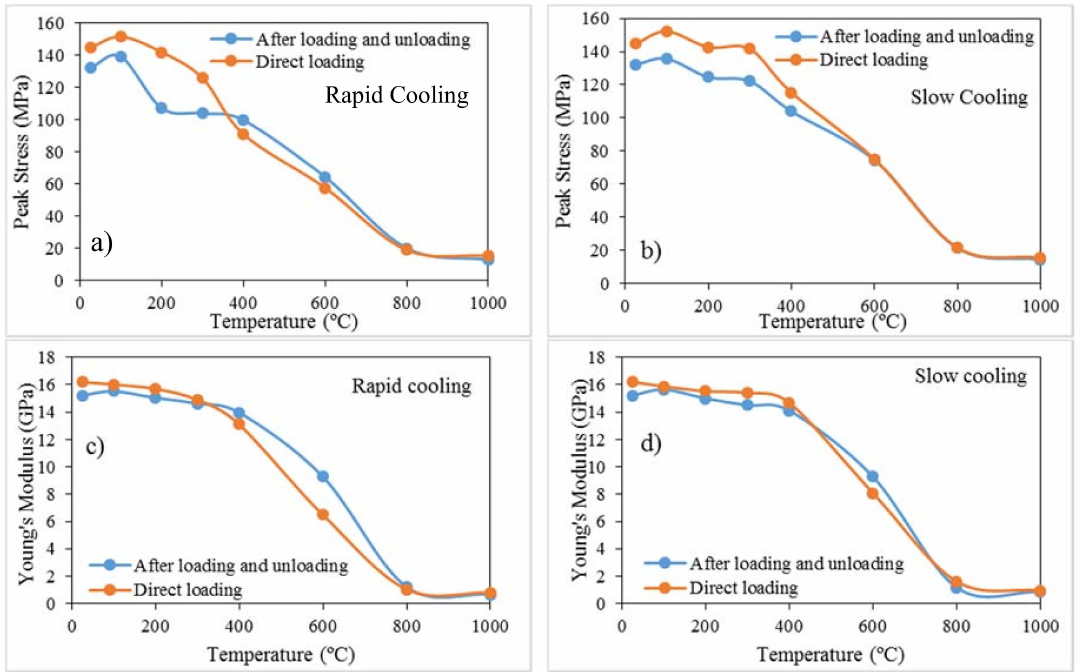
Figure 12. Comparison of UCS values and Young’s modulus values during direct loading and after loading and unloading cycles for specimens treated with rapid and slow cooling. ( a ) Peak strength under rapid cooling; ( b ) Peak strength under slow cooling; ( c ) Young’s modulus under rapid cooling; ( d ) Young’s modulus under slow